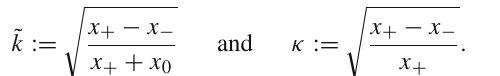
the ratio K / K max for different values of γ := ¯ h 2 H 2 tom/darker to top/lighter) γ = 1 / 8, γ = 3 / 8, γ = 5 / 8 and γ = 7 / 8. The tunnelling probability for the case of the creation of an expanding universe from nothing ( K = 0) is indicated by a dashed blue